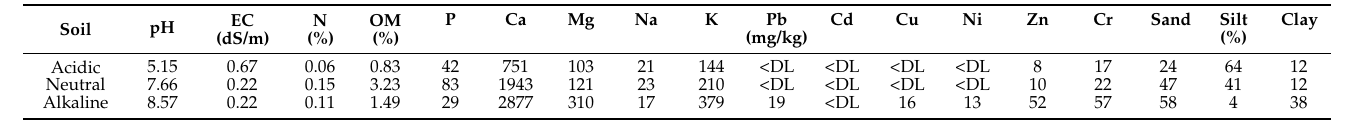
Table 1. Physicochemical characteristics of